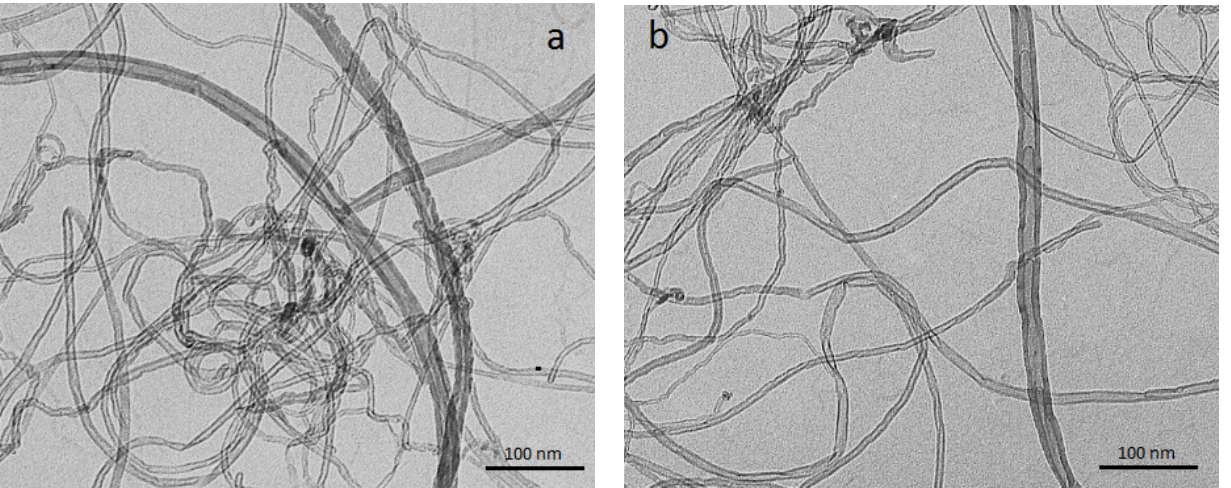
in the post-discharge 2